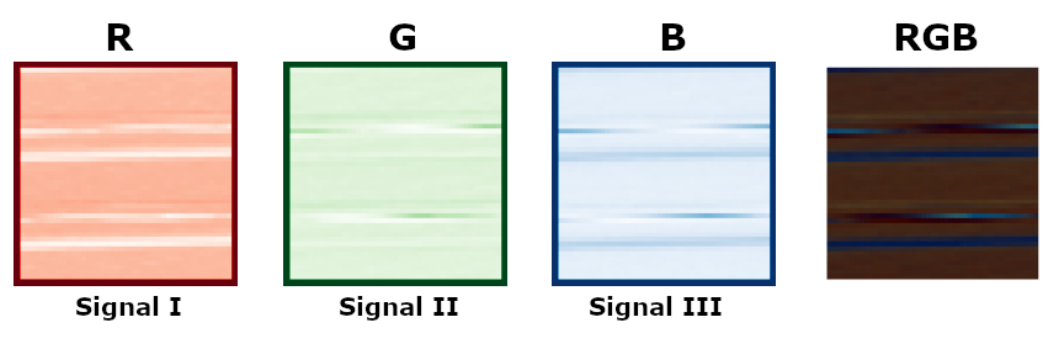
Figure 13. A ground truth RGB image as a combination of three channels, each of them with an electrocardiogram signal.